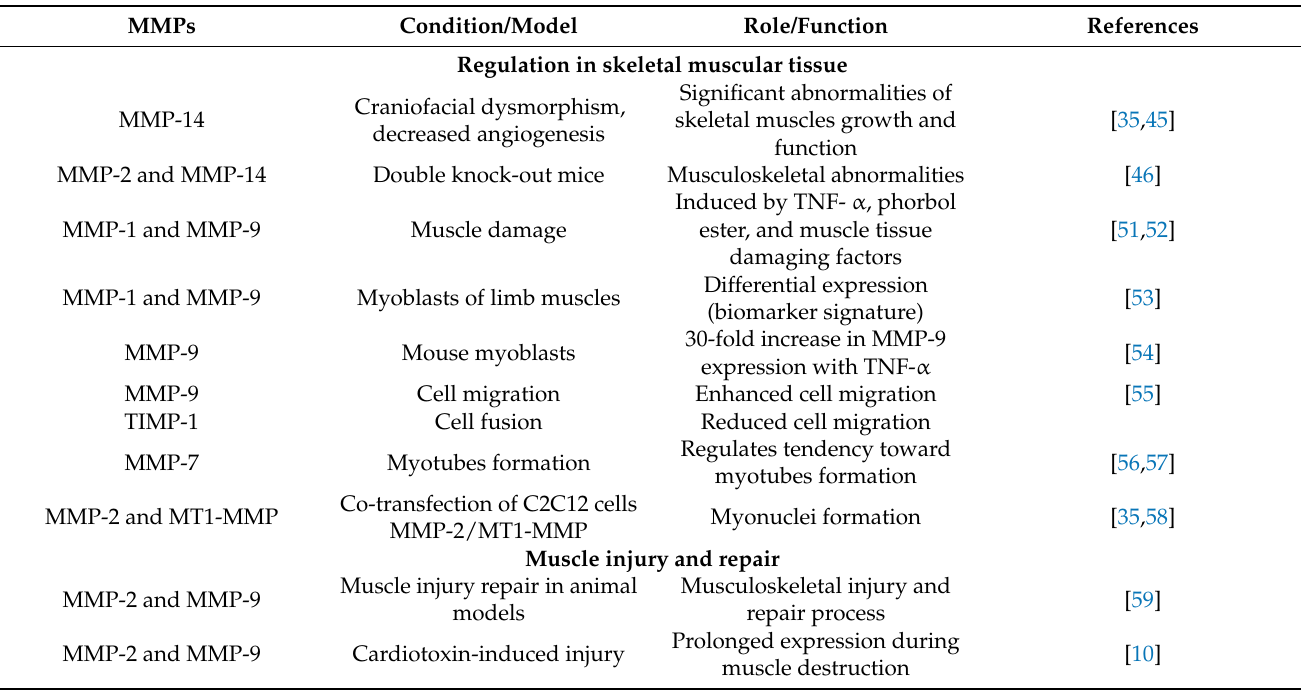
Table 2. Contribution of the MMPs in the muscle function/muscle